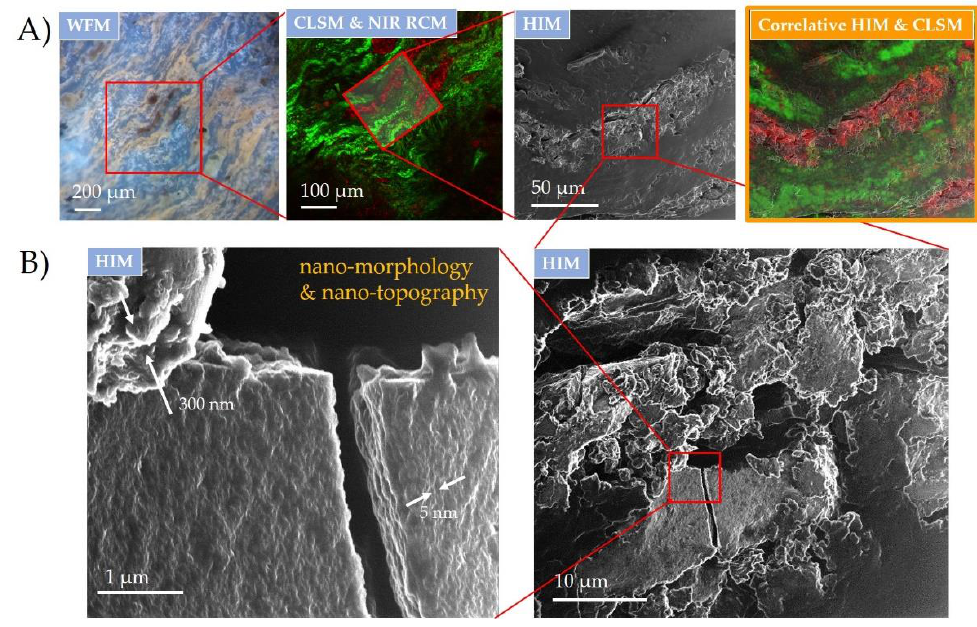
Figure 4. Surface topography of inflammatory wear debris distributed in periprosthetic tissue characterized down to nm scale using correlative HIM and optical CLSM and NIR RCM. ( A ) CM registration and overlap of wear debris site in the tissue sample on a micron scale; ( B ) wear debris surface nanotopography using HIM with distinct features from a few nm to a few hundred nm in size indicated with the white arrows. Excitation sources: WFM (LED; λ = 400 nm); CLSM and NIR RCM ( λ = 561 nm and λ = 765 nm) and HIM SE (30 keV He ion energy with 1.7 pA ion current and 2 nm pixel step